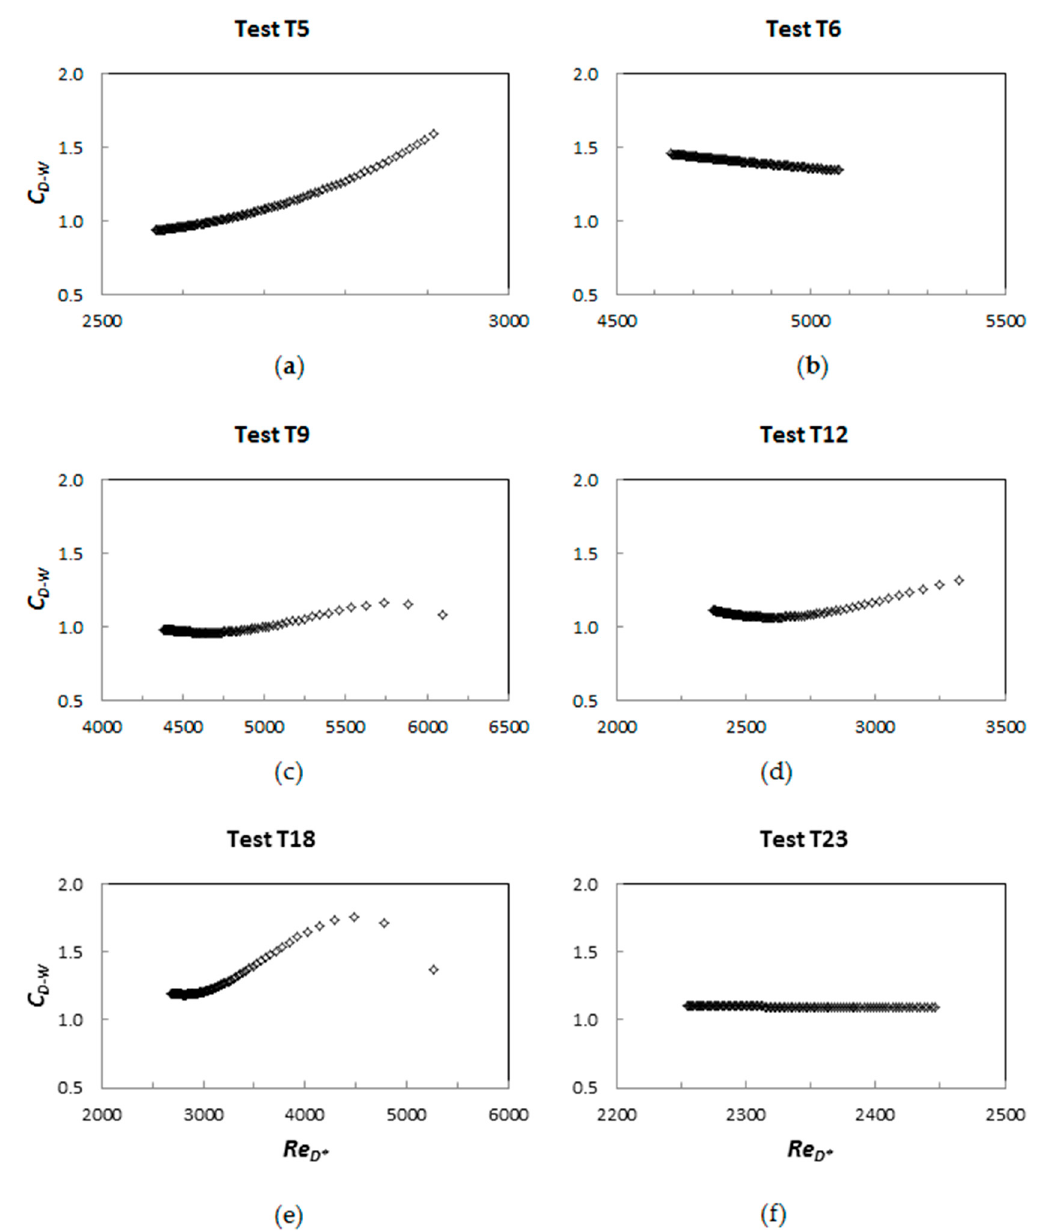
Figure 5. Drag coefficients obtained following the procedure of Wang et al. [1]: ( a ) T5; ( b ) T6; ( c ) T9; ( d ) T12; ( e ) T18; ( f ) T23.